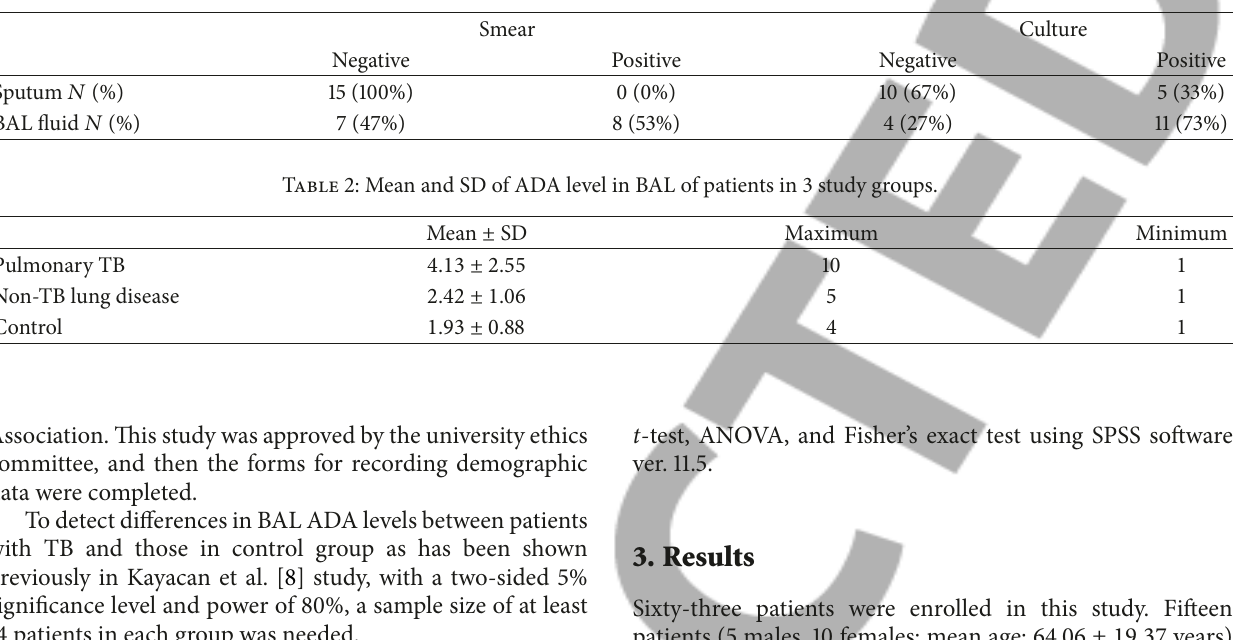
Table 1: Frequency of patients with pulmonary TB based on sputum smear sputum culture and BAL culture.